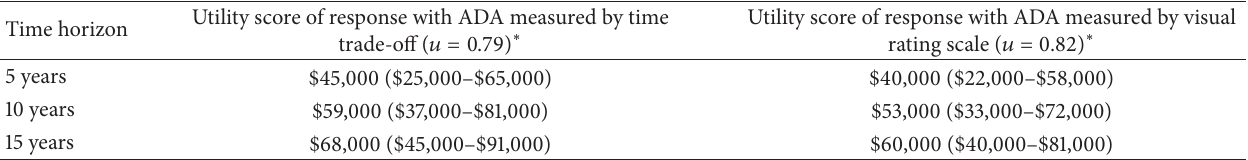
Table 1: Incremental cost-effectiveness ratios between adalimumab treatment and no adalimumab treatment but instead ongoing medical